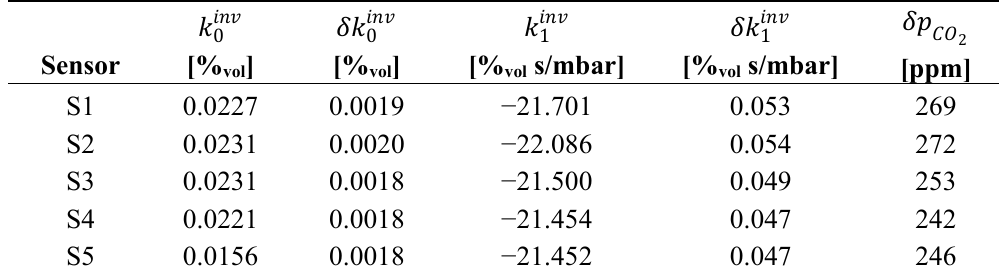
Table 3. Calibration constants of Equation (5) from the inverse calibration method (reference gas: air with added CO , outer matrix: 2